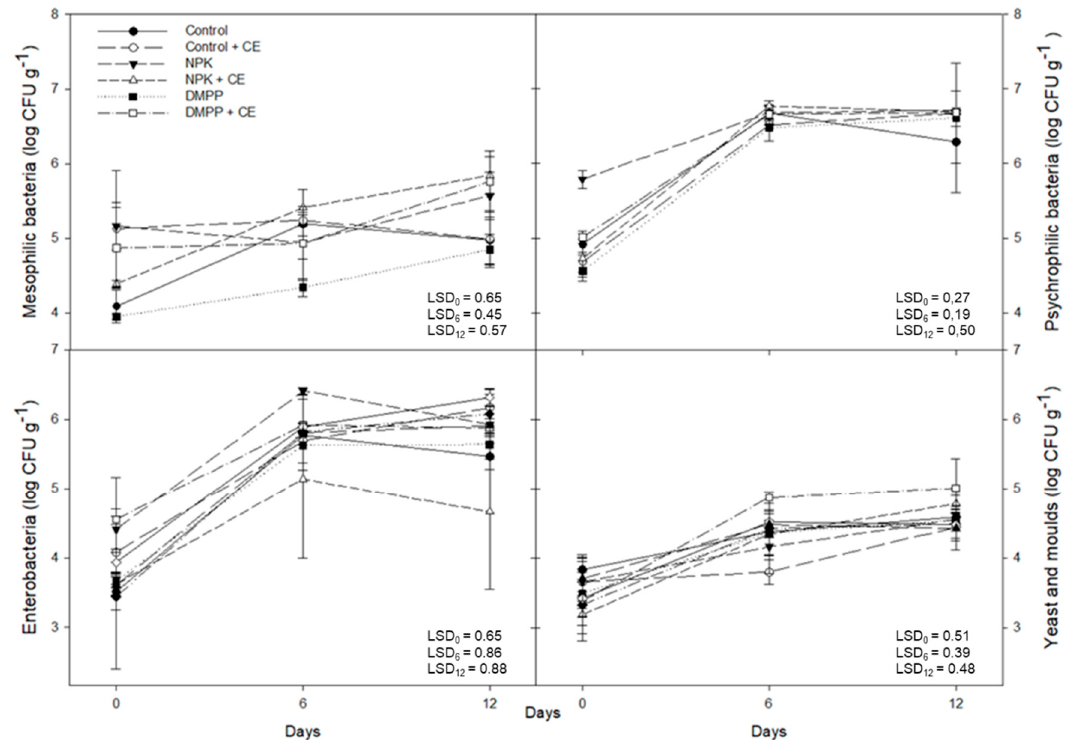
Figure 5. Mesophilic bacteria, psychrophilic bacteria, enterobacteria and yeast and moulds counts (log CFU g − 1 ) of fresh spinach leaves grown after different fertilizer treatment and storage at 4 °C for up to 12 days. Control; Control + CE, control with compost extract; NPK, inorganic NPK fertilizer 15-15-15; NPK + CE, inorganic NPK with compost extract; DMPP, ENTEC Nitrofoska ® plus the nitrification inhibitor (IN) 3,4-dimethylpyrazole phosphate (DMPP); DMPP + CE, the nitrification inhibitor (IN) with compost extract.